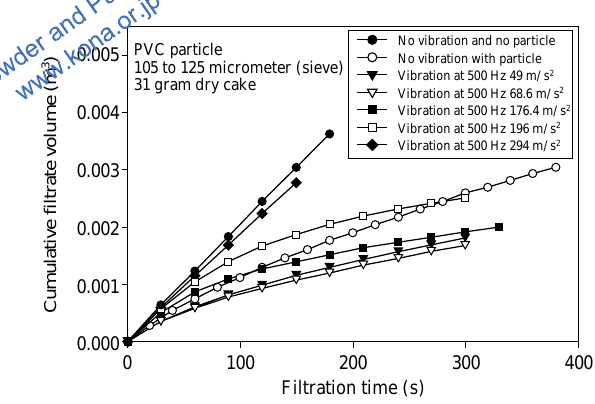
The filtrate volume collected with 500 Hz vibration applied to the filter medium during cake filtration experiments.